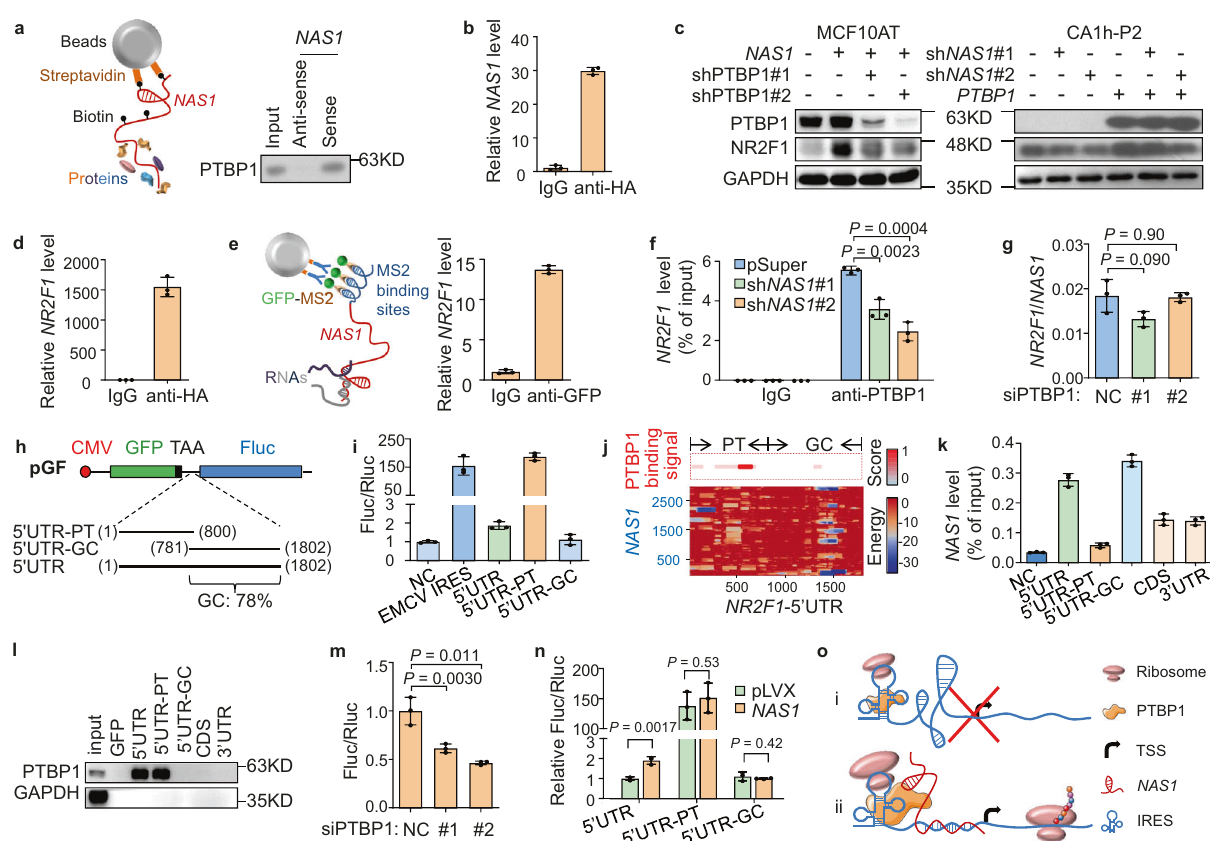
Fig. 5 NAS1 and PTBP1 cooperatively enhance the IRES function of NR2F1 -5 ′ UTR. a PTBP1 pulldown by NAS1 RNA in MCF10CA1h lysates. A schematic of the RNA pulldown assay was shown on the left. b NAS1 RNA level in RIP assays for PTBP1-interacting RNAs in MCF10CA1h expressing PTBP1-HA. c NR2F1 protein level after PTBP1 knockdown in NAS1 -overexpressing MCF10AT (left) or after PTBP1 overexpression in CA1h-P2 with NAS1 knockdown (right). d NR2F1 mRNA level in RIP assay for PTBP1-interacting RNAs in MCF10CA1h expressing PTBP1-HA. e RIP assays with the MS2 – GFP system to analyze the RNA – RNA interaction between NAS1 and NR2F1 . A schematic of the assay was shown on the left. f RIP analyses of the binding of PTBP1 to NR2F1 mRNA in CA1h-P2 with NAS1 knockdown ( n = 3 replicates from one experiment). g RIP analyses of RNA – RNA interaction between NAS1 and NR2F1 in MCF10CA1h with PTBP1 knockdown. The ratios of NR2F1 to NAS1 were shown ( n = 3 replicates from one experiment). h Schematic of the pGF plasmid and the NR2F1 -5 ′ UTR segments for IRES activity analyses. Numbers in parentheses indicate the start and end base-pair positions of the segments. GFP and fi re fl y luciferase are transcribed by the same CMV promoter, while luciferase translation is dependent on the IRES activity of the insert sequence between the two genes. i IRES activity of NR2F1 -5 ′ UTR was analyzed by a dual-luciferase reporter assay of the pGF system ( n = 3 wells from one experiment). EMCV IRES was used as a positive control. NC, negative control. j PTBP1 binding sites on NR2F1 -5 ′ UTR predicted by catRAPID (top), and NAS1 binding sites on NR2F1 -5 ′ UTR predicted by IntaRNA (bottom). k RIP analyses of the binding of NAS1 to different regions of NR2F1 mRNA. l RNA pulldown assays for interaction between PTBP1 and regions of NR2F1 mRNA. m Effect of PTBP1 on IRES activity of NR2F1 -5 ′ UTR-PT ( n = 3 wells from one experiment). n Effect of NAS1 overexpression on IRES activity of NR2F1 -5 ′ UTR ( n = 3 wells from one experiment). o Schematic of the mechanism by which PTBP1 and NAS1 regulate the IRES activity of NR2F1 -5 ′ UTR. PTBP1-mediated NR2F1 translation was halted by the GC-rich segment (i) and could be activated by the binding of NAS1 (ii). TSS transcription start site. Data represent mean±SD. Statistical signi fi cance was determined by a two-tailed unpaired t test. Experiments were repeated at least three times independently with similar results; data from one representative experiment are (Supplementary Table 4) were enriched in the cells with or without NR2F1 overexpression, respectively (Fig. 6g), indicating that NR2F1 adversely affects the downstream genes of Δ Np63.